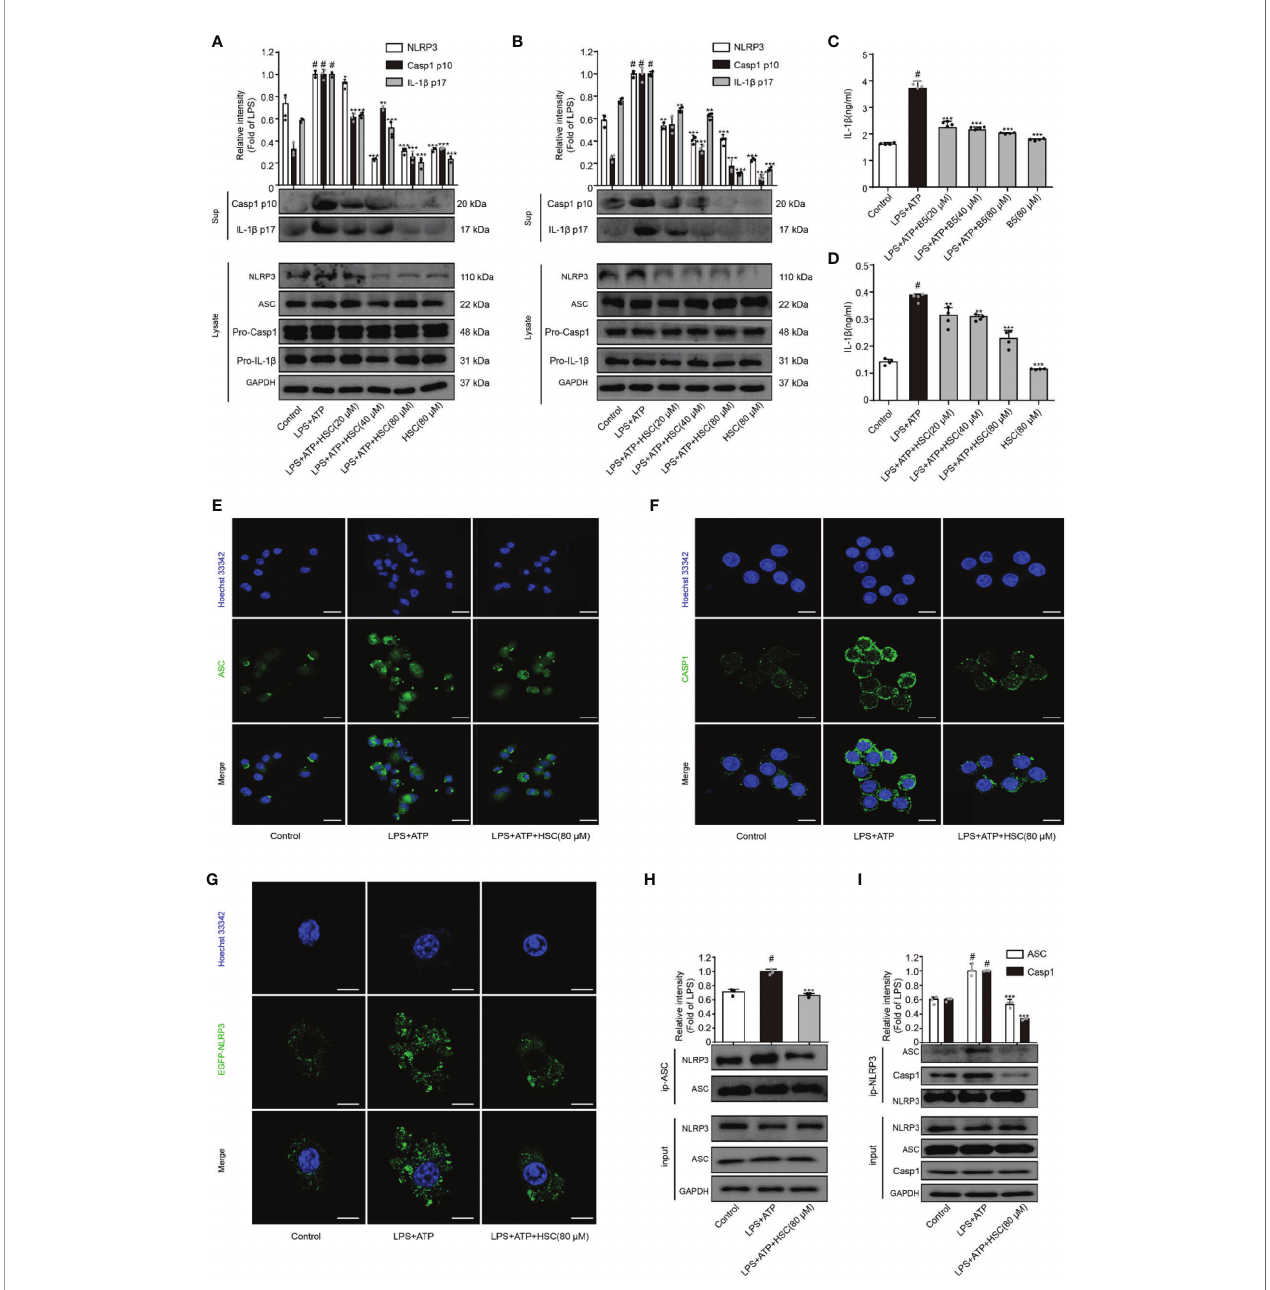
FIGURE 3 | HSC inhibit the activation of NLRP3 in fl ammasome. J774A.1, THP-1 cells treated with HSC for 4 h, LPS (1 m g/mL) was added to stimulate for 6 h, followed by ATP (5 mM) co-culture for 30 min; (A, B) NLRP3 in fl ammasome related proteins NLRP3, ASC, caspase1, caspase-1p20, IL-1 b , and IL-1 b p17 were determined by western blotting in J774A.1 (A) , THP-1 (B) cells; (C, D) The level of IL-1 b was determined by ELISA in J774A.1 (C) , THP-1 (D) ; (E) ASC activation was determined by immuno fl uorescence in THP-1 cells; (F) Cleaved-caspase-1 activation was determined by immuno fl uorescence in J774A.1 cells; (G) Plasmids of EGFP- NLRP3 were transfected into J774A.1 cells for 48 h, NLRP3 activation was determined by immuno fl uorescence; (H) The proteins were immunoprecipitated with ASC using magnetic beads, and the immunocomplexes were identi fi ed by western blotting. (I) Using magnetic beads, the obtained proteins were immunoprecipitated with NLRP3, and immunocomplexes were evaluated by western blotting; (Scale bar = 20 m m); # P < 0.001 compared to control alone group; * P < 0.05, ** P < 0.01, and *** P < 0.001, versus the LPS+ATP group,